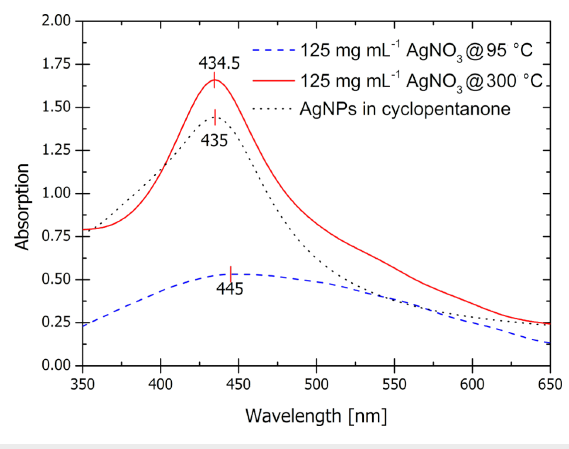
Figure 3: UV–vis absorption spectra of a nanocomposite on a silica wafer containing 0.5 mL of 125 mg·mL − 1 AgNO 3 precursor solution after different post-exposure heat treatments. Blue dashed curve – after 95 °C for 10 min, red solid curve – after an additional 300 °C for 30 min and black dotted curve – AgNPs in cyclopentanone for com-